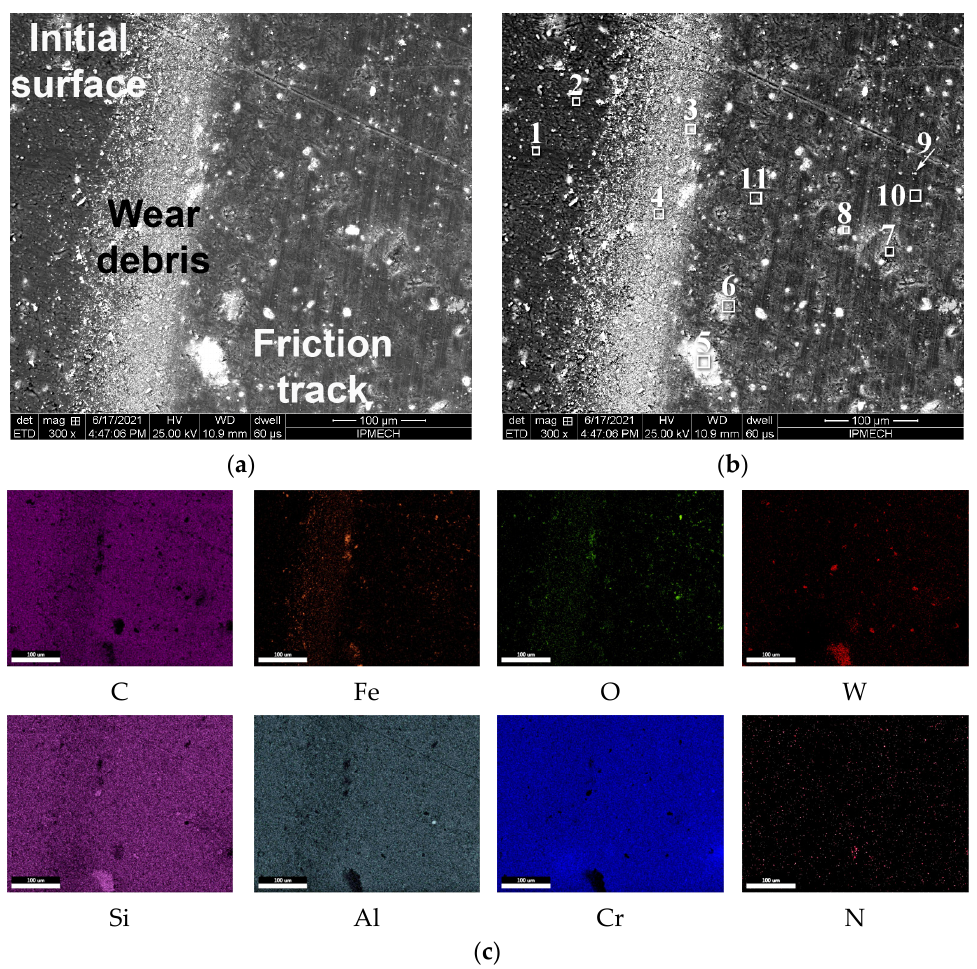
Figure 4. Image of the sample surface in area 2 at the boundary of the friction track: ( a )—characteristic zones, ( b )—zones of X-ray spectral analysis, ( c )—maps of the distribution of chemical elements.